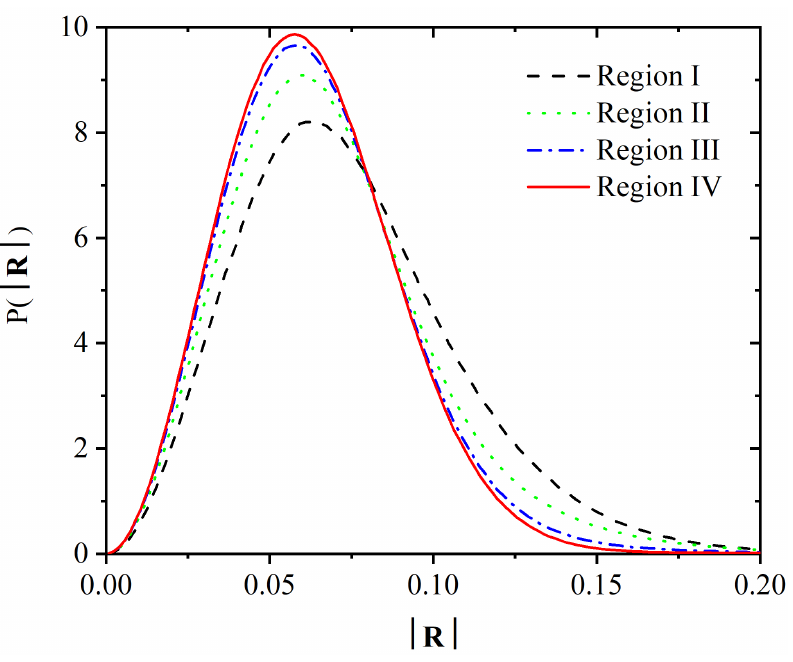
Figure 14. Distribution of the modulus of the vector joining the position of a given monomer and the centroid of its Voronoi cell, | R | , for the four different